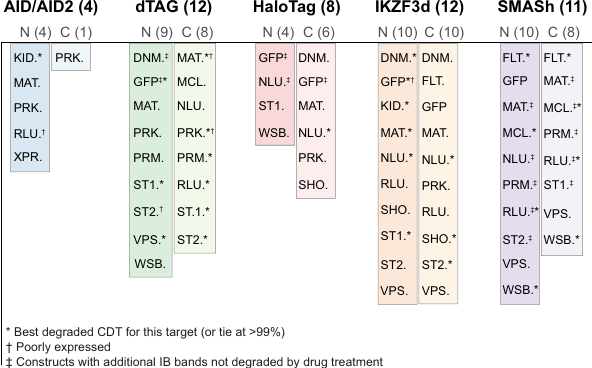
unique mechanism of action (Supplementary Figs 9, 10). Between different targets, the kinetics ranged from clearance of both the untagged POI and the degron-tagged POI within 24 h (VPS4A, Sup- plementary Fig. 10c) to 5 days (PRMT5 and WSB2, Supplementary Fig. 10b, d) to retention of the degron-tagged POI for up to 10 days (MCL1-SMASh-C, Supplementary Fig. 9d).